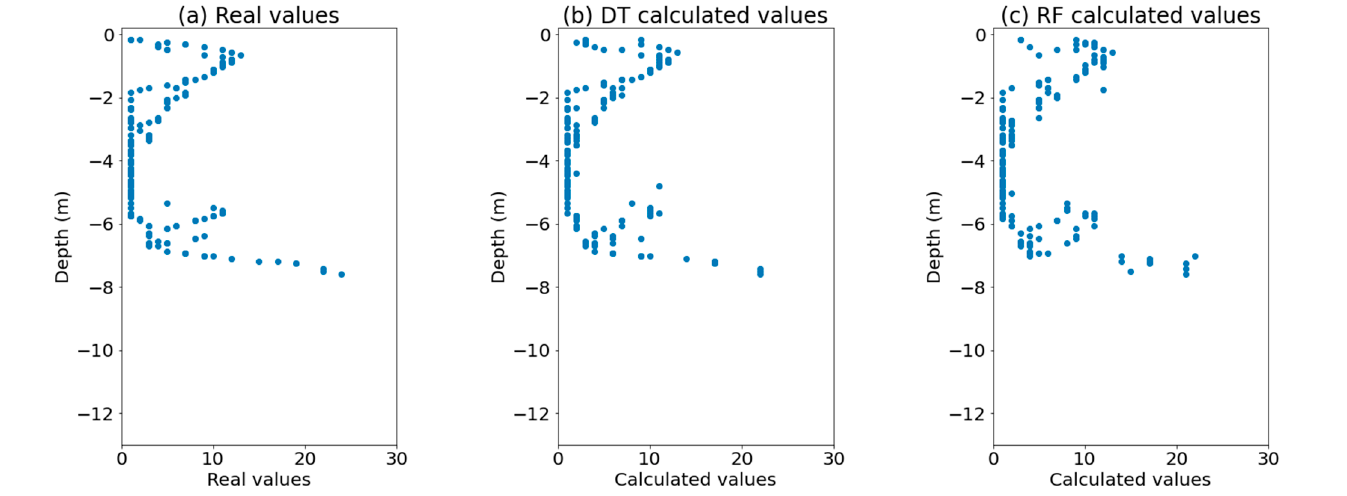
Figure 17. Real and calculated values for site 3 considering depth. ( a ) Real values. ( b ) Values calcu- lated by DT. ( c ) Values calculated using RF.